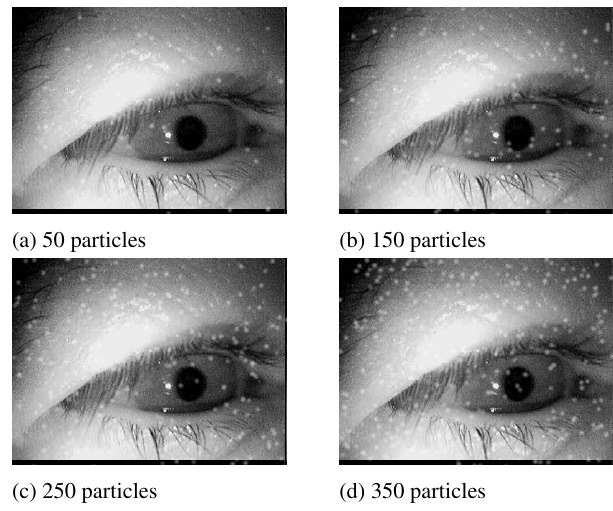
Figure 7 . Simulation results for di ff erent amounts of parti- cles on one image. The particle size group is set to 2 and the focal length is 5.6.